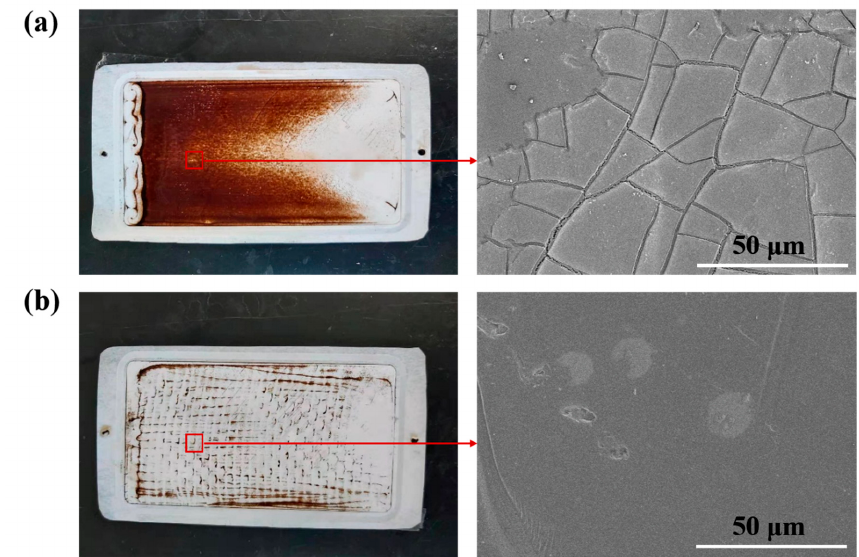
Figure 10. Photographs and SEM images of the contaminated membrane ( a ) without the turbulence promoter and ( b ) with the turbulence promoter (SSTS: 500 ppm HA, pH = 4; TMP = 0.5 MPa).